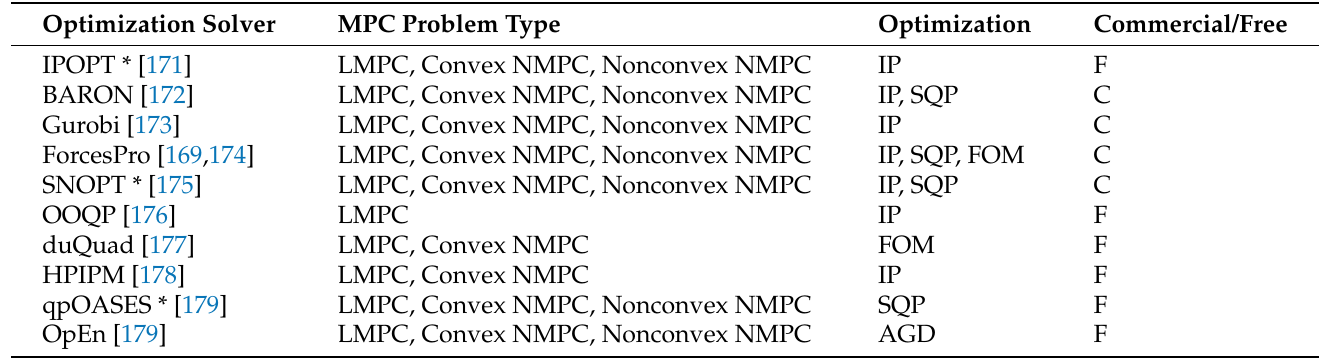
Table 3. Common solvers for MPC along with the application type, optimization method, and availability of open source). Optimization